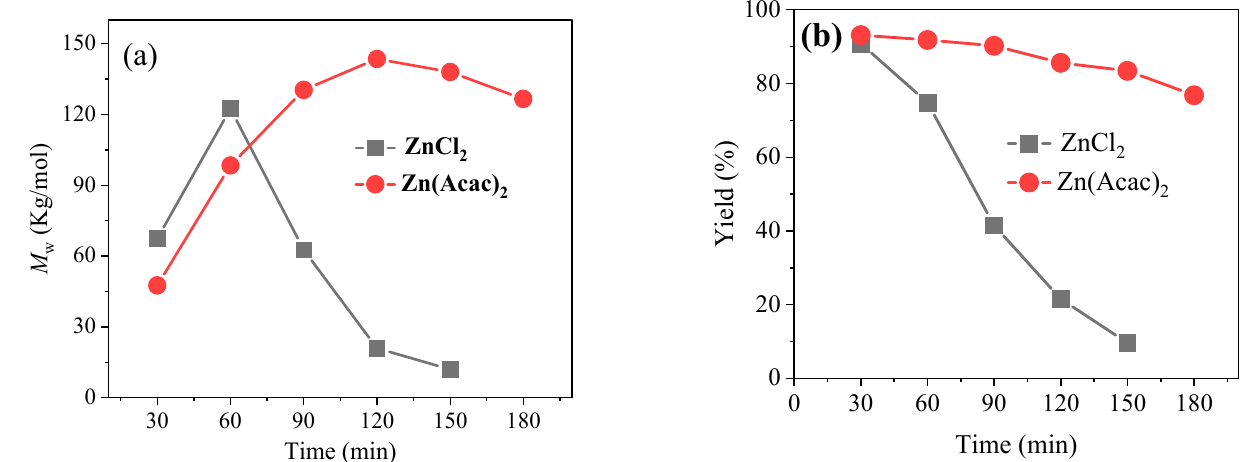
Figure 4. The effects of reaction time on the ( a ) M w and ( b ) yield of PBC polymer over ZnCl 2 and Zn(Acac) 2 . Reaction conditions: molar ratio of Zn 2+ to DPC 0.1%, reaction temperature 200 °C.